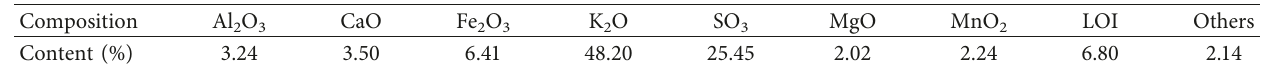
Table 5: Chemical composition of strong oxidant GH.